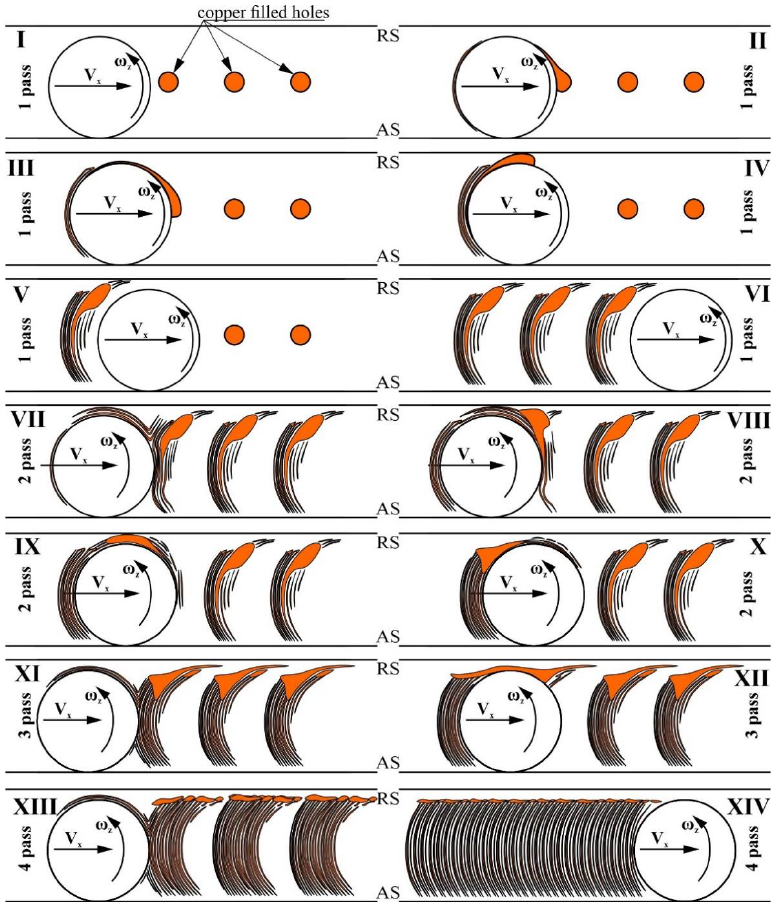
Figure 15. Schematic diagrams showing the FSP stirring and transfer stages that occur during each of the four passes. Materials 2023 , 16 , 1070